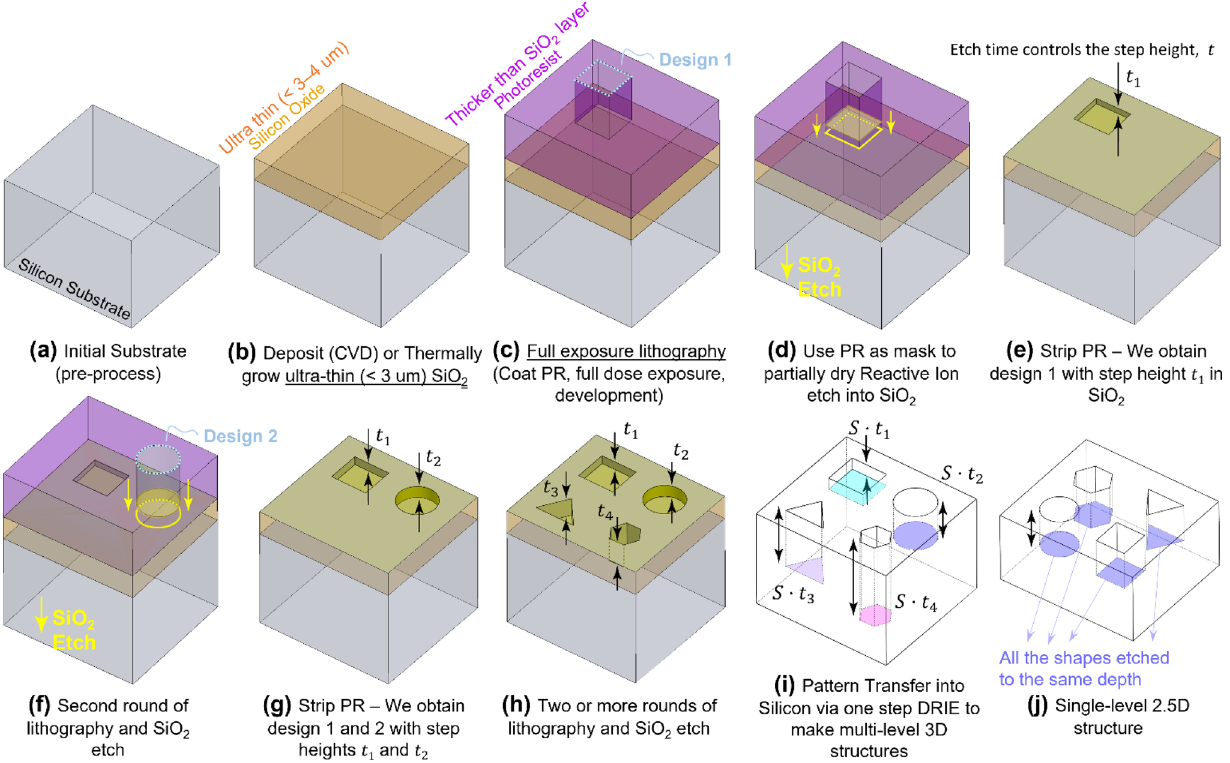
Figure 2. Process flow for creation of multi-level structures using novel approach. ( a ) Clean bare wafer without features; ( b ) Intermediate ultra-thin masking material is deposited—in our case, SiO 2 is CVD deposited; ( c ) Photoresist (PR) spinning is uniform, this process is not hindered because it is thicker than the underlying SiO 2 layer, exposure of Design 1, and development; ( d ) Using PR as mask layer, the underlying SiO 2 is etched to a precise amount, t 1 ; ( e ) Stripping PR; ( f ) Second round of lithography is performed—in this situation PR thickness is at least 1.5 times the maximum SiO 2 feature thickness already on the wafer, thus spin coating process is successful, yielding a thin conformal coat all over the 3D featured SiO 2 . This time design 2 was etched in SiO 2 to a different depth, t 2 ; ( g ) After two rounds of litho, a 2-level structure is made on the SiO 2 ; ( h ) After two more rounds of litho, 2 more levels can be made. In theory, n rounds of lithography is able to make